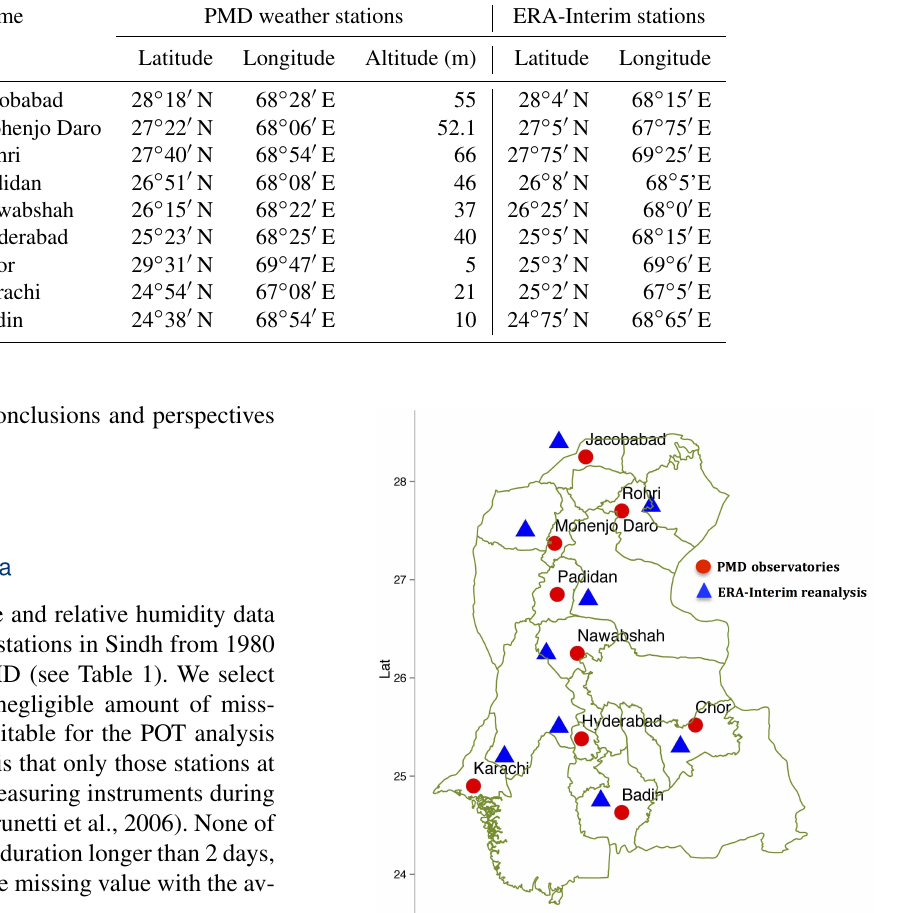
The gridded daily maximum temperature and relative hu- midity data of ERA-Interim reanalysis are obtained from the ECMWF Public Datasets web interface (http://apps.ecmwf. int/datasets/). ERA-Interim is generated by the ECMWF model with a resolution of 0 . 75 ◦ × 0 . 75 ◦ (Dee et al.,